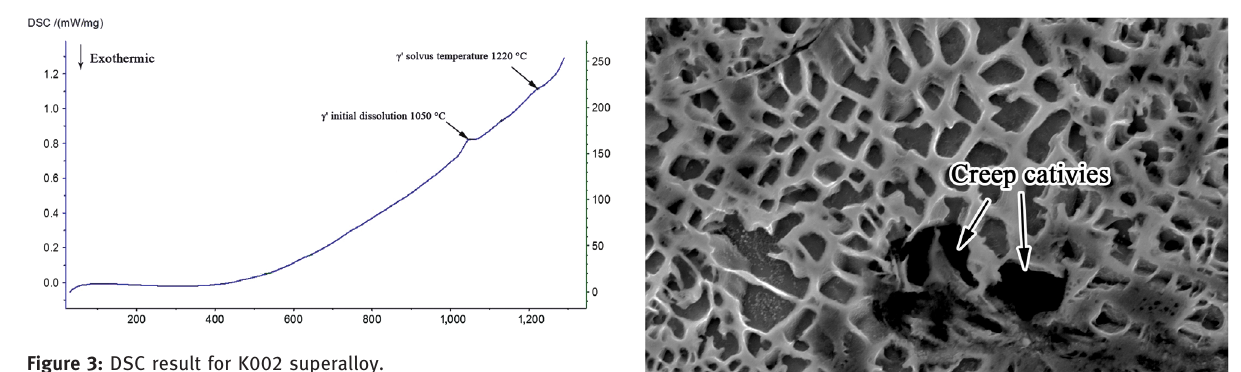
Figure 3: DSC result for K002 superalloy.